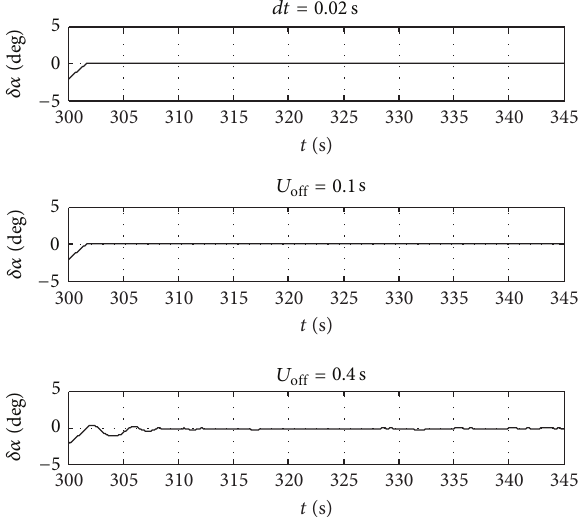
Figure 32: Simulation result of attack angle deviation.